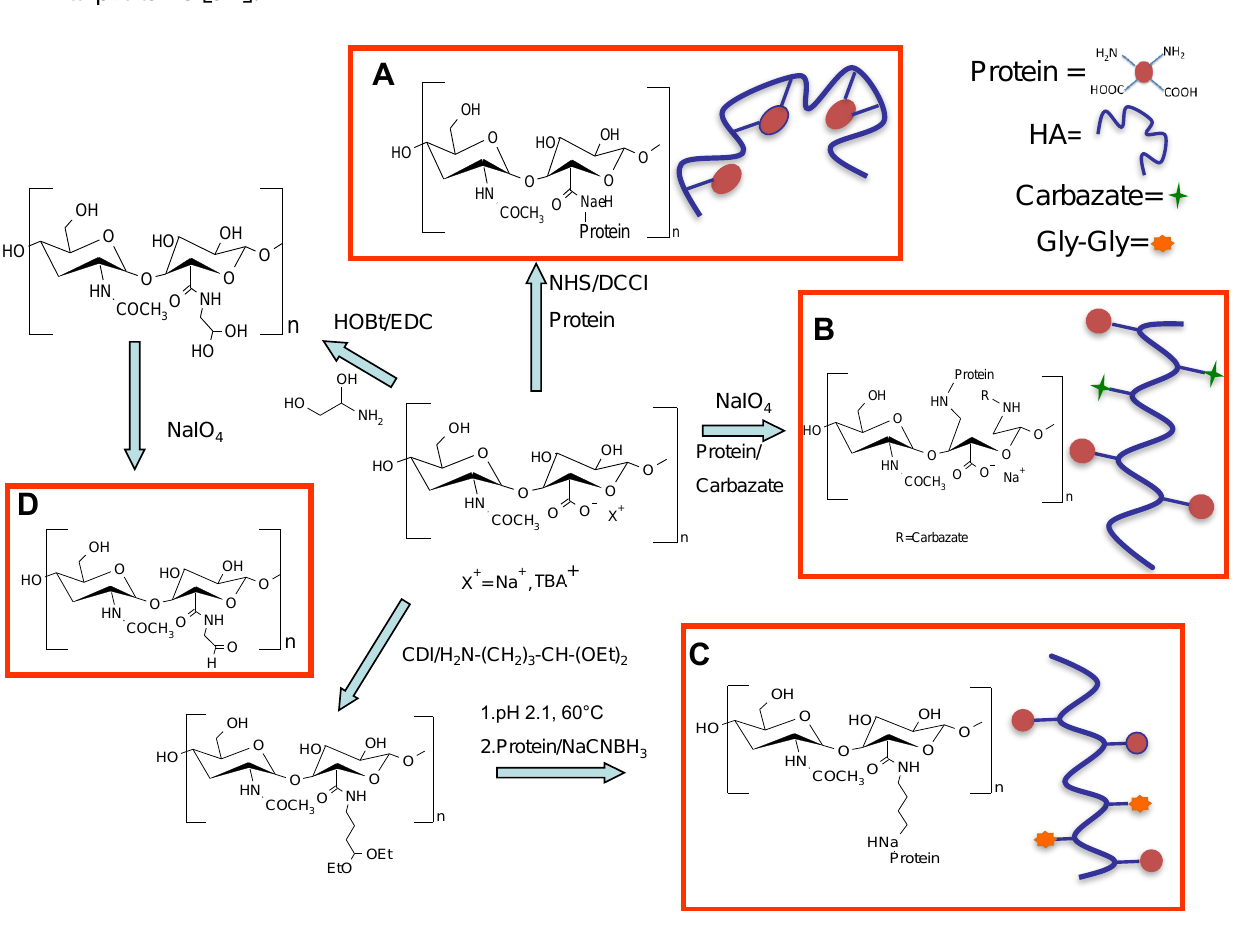
Figure 11. Schematic representation of different HA activation methods and the following conjugation to proteins: ( A ) random conjugation of amino groups of proteins to carboxylic groups of HA [24]; ( B ) Slight HA oxidation in the presence of periodate and conjugation of HA–ALD with N -terminal primary amine group of proteins [78,79]; ( C ) Modification of HA with an acetal spacer for selective conjugation to the N -terminal amino groups after hydrolysis to the active aldehyde of the polymer [65]; and ( D ) Coupling of amino glycerol to HA carboxylic groups and partial oxidation for selective N -terminal conjugation to proteins [82].